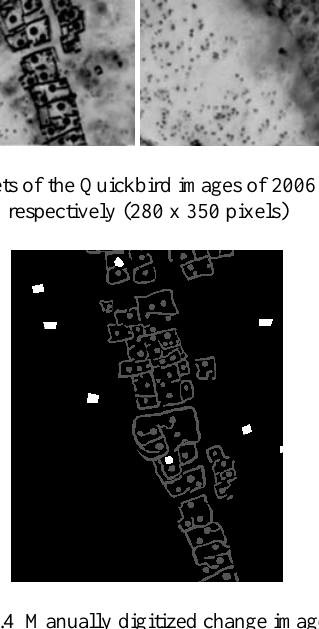
Fig.4 Manually digitized change image